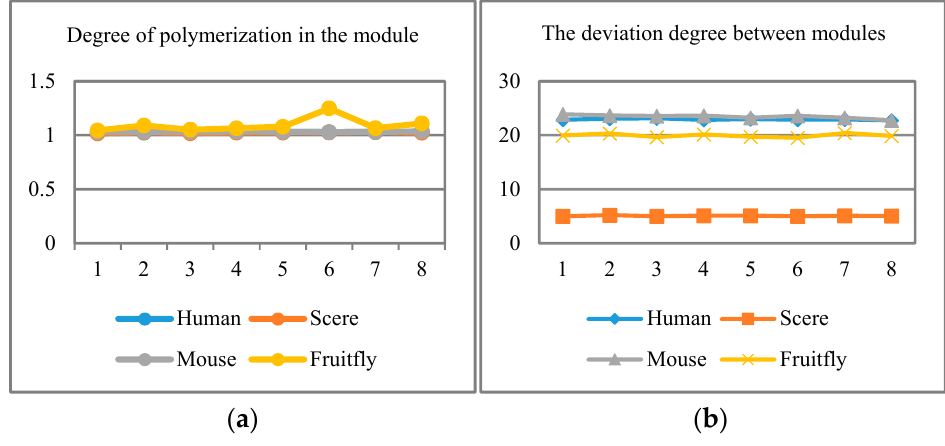
Figure 4. ( a ) Degree of polymerization in the module; ( b ) deviation degree between modules. Appl. Sci. 2017 , 7 , 412